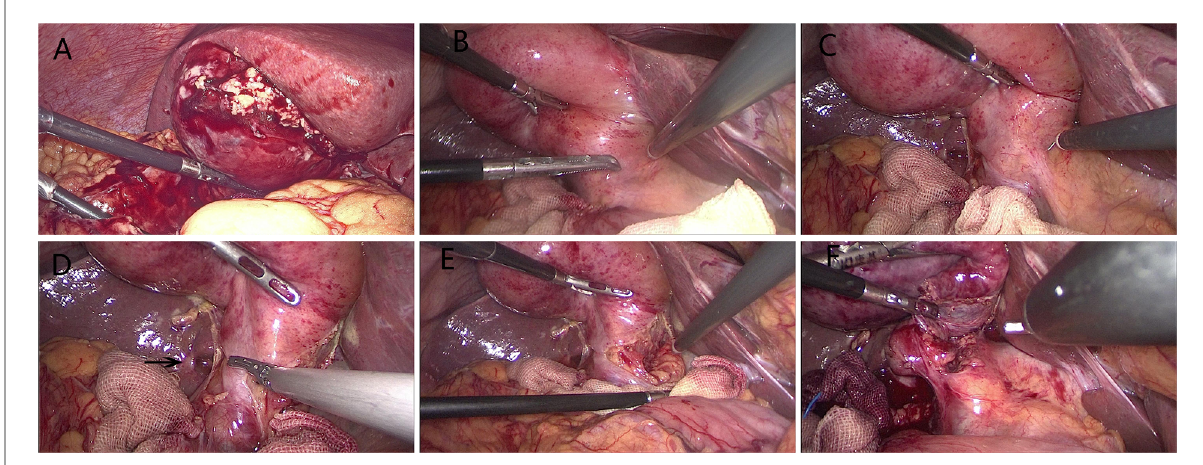
FIGURE 2 Laparoscopic cholecystectomy for ACC. ( A ) Typical fi nding of grade II ACC with empyema and gangrene. ( B ) Typical fi nding of grade I ACC with hyperemia and edema. ( C ) Effective retraction of the gallbladder to develop a plane in Calot ’ s triangle area. ( D ) Dissection from the posterior leaf of the peritoneum covering the neck of the gallbladder and above Rouviere ’ s sulcus (arrow). ( E ) Maintaining the plane of dissection on the gallbladder surface. ( F ) Dissecting the lower part of the gallbladder bed to obtain the critical view of